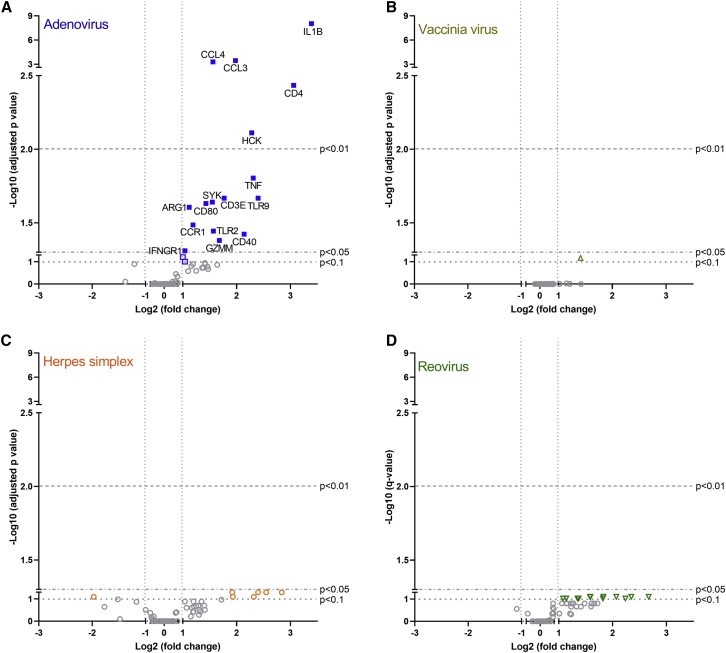
Impact of Different Oncolytic Viruses in the Tumor MicroenvironmentComparisons were made between RNA expression profiles from the different virally treated groups versus PBS-treated group. (A–D) Viral treatment used in the group compared to PBS-treated animals: (A) adenovirus, (B) vaccinia virus, (C) herpes simplex virus, and (D) reovirus. The plots indicate the names of those genes for which there is a statistically significant difference (adjusted p value < 0.05) and an expression change of at least double or half compared to reference group (−1 > log2 fold change > 1).